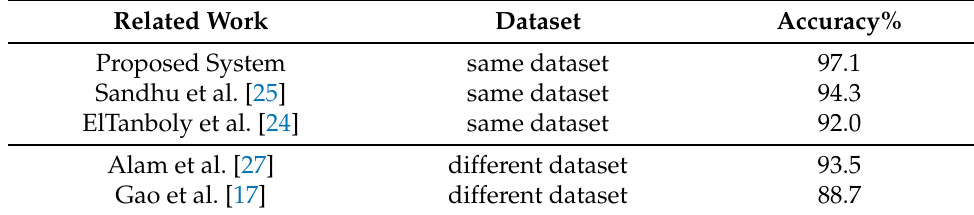
Table 5. Related work accuracy